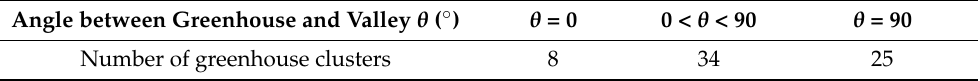
Table 2. The number of greenhouse clusters according to different greenhouse azimuths. Angle between Greenhouse and Valley θ ( ◦